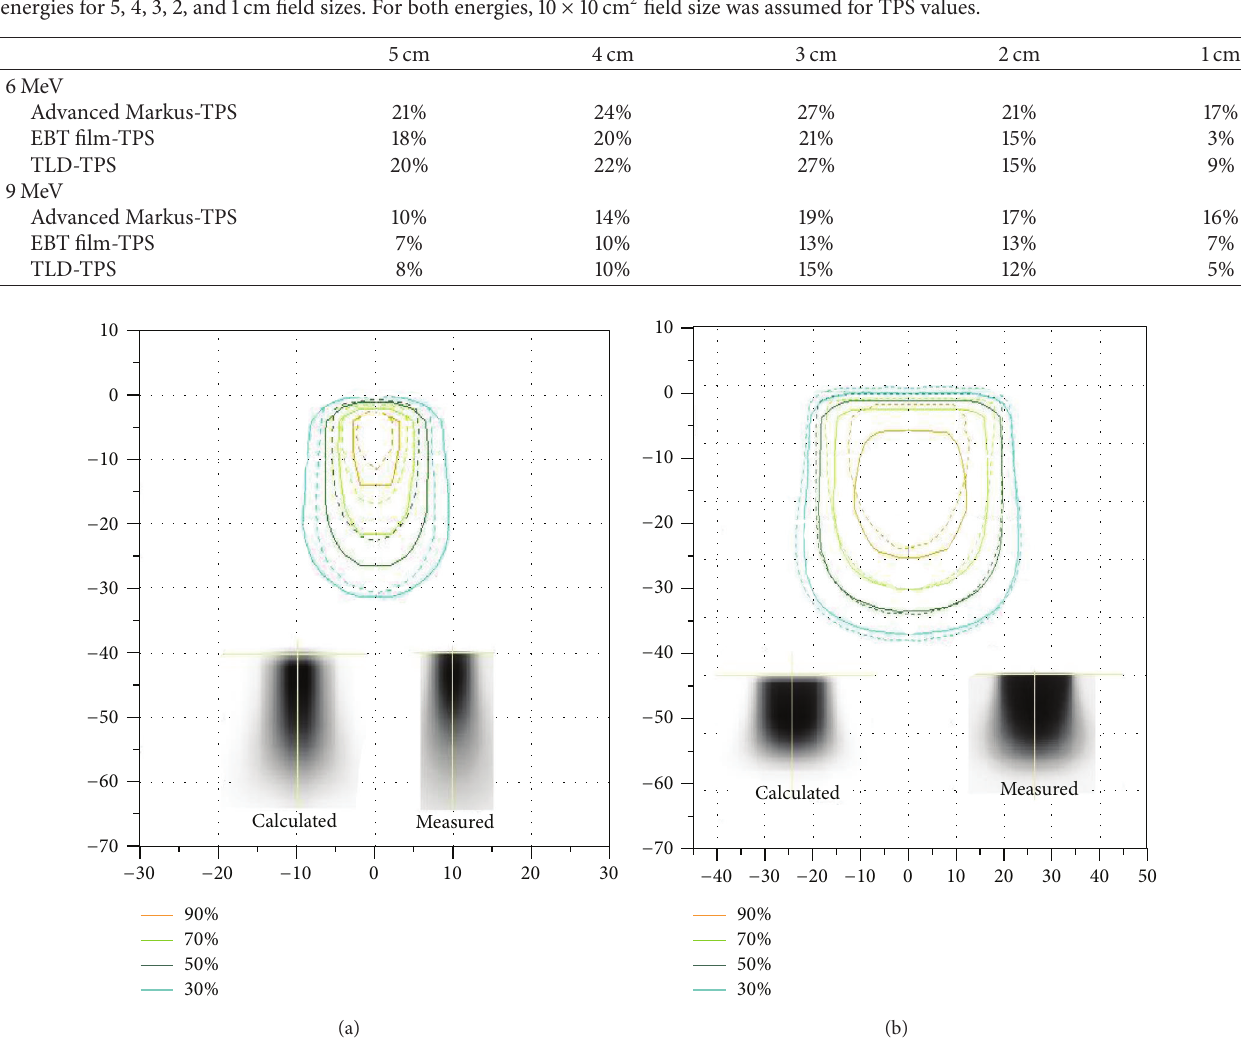
Figure 5: Sagittal isodosecomparisons of a 9MeV beam along thecentral axis for1 (a)cm and 4 (b)cm circular cut-outsusing a 5cm diameter circular cone. Solid lines represent calculations and dotted lines represent measurements ( 𝑥 -axis and 𝑦 -axis are in